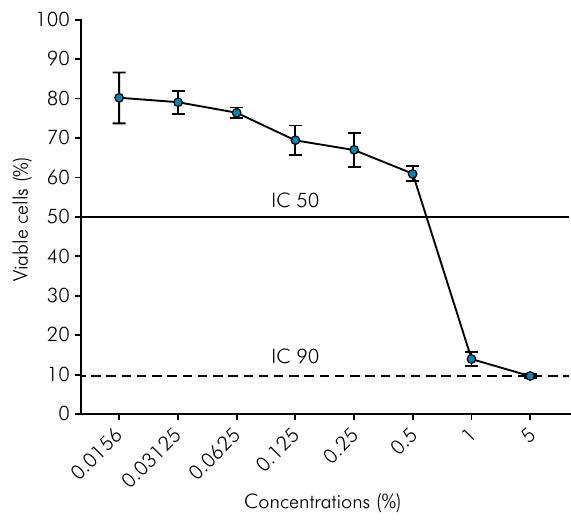
Figure 2. The maximum glucocorticoid dose that preserves at least 50% (IC 50) and 90% (IC 90) of cell viability of MC3T3-E1 cells was first evaluated using eight doses of budesonide